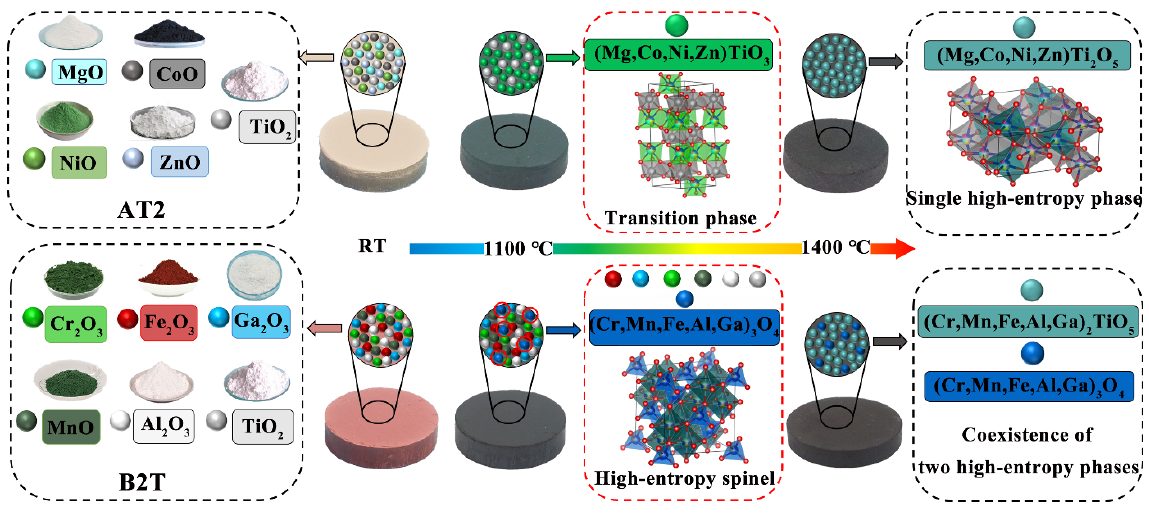
Fig. 7 Synthesis process of high-entropy (Mg,Co,Ni,Zn)Ti 2 O 5 in AT2 and high-entropy (Cr,Mn,Fe,Al,Ga) 2 TiO 5 in